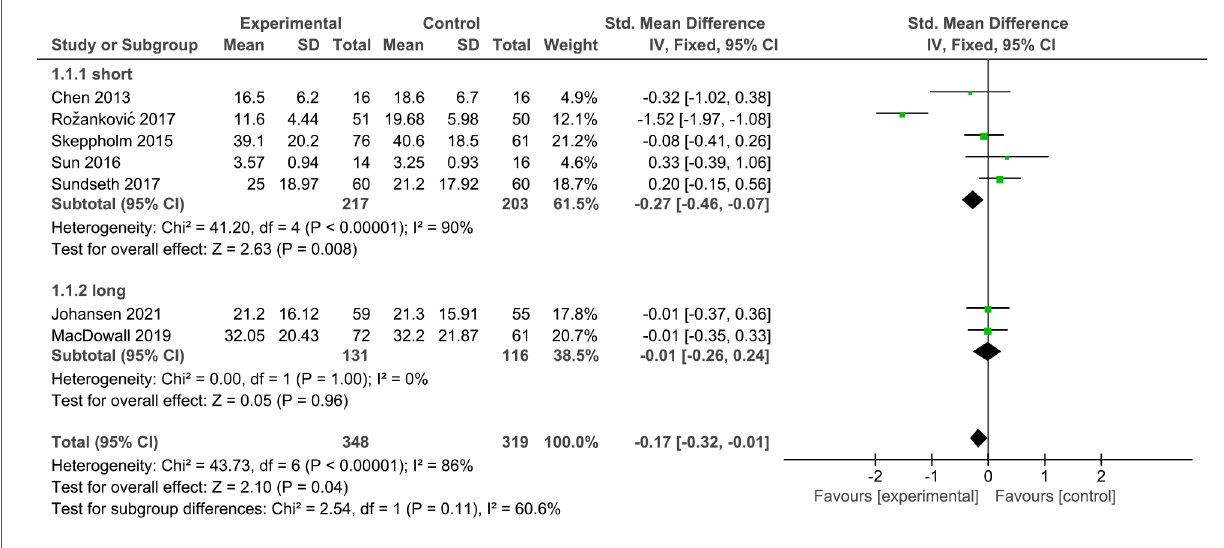
FIGURE 3 Comparison of NDI score between the discover cervical disc arthroplasty (DCDA, “ experimental ” ) group and the anterior cervical discectomy and fusion (ACDF, “ control ” ) group.